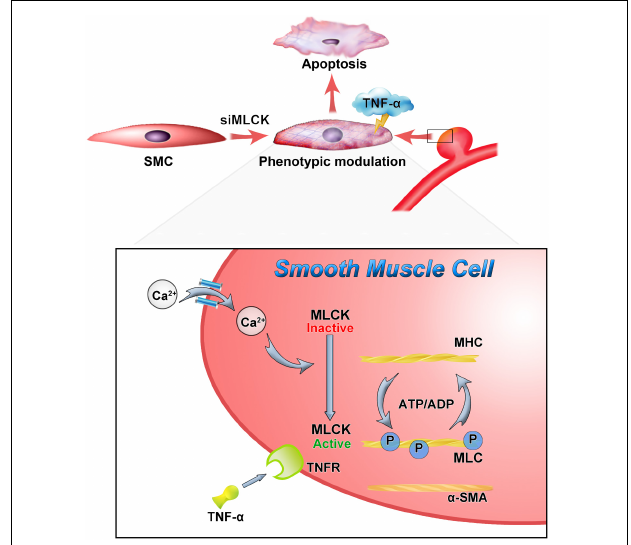
FIGURE 5 | Down-regulation of MLCK weaken the contractile function and with vulnerably reaction to inflammation. The loss of MLCK expressed as phenotypic modulation and calcium dependent phosphorylation was further disturbed. In the TNF environment, the morphologically altered smooth muscle is weaker and more susceptible to